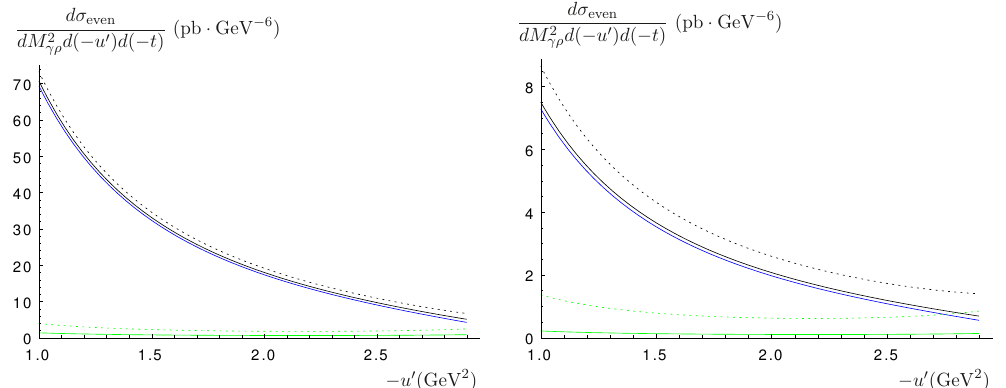
Figure 7 . Differential cross section for a photon and a longitudinally polarized ρ meson production, for the proton (left) and the neutron (right), at M 2 = 4 GeV 2 . Both u and d quark contributions are γρ included. In black the contributions of both vector and axial amplitudes, in blue the contribution of the vector amplitude, and in green the contribution of the axial amplitude. Solid: “valence” model, dotted: “standard” model. This figure shows the dominance of the vector GPD